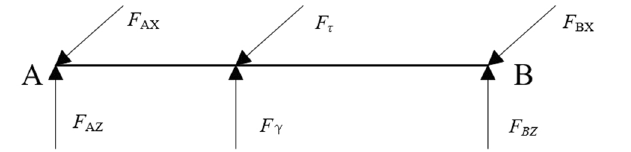
Figure 7. S 1 axial force